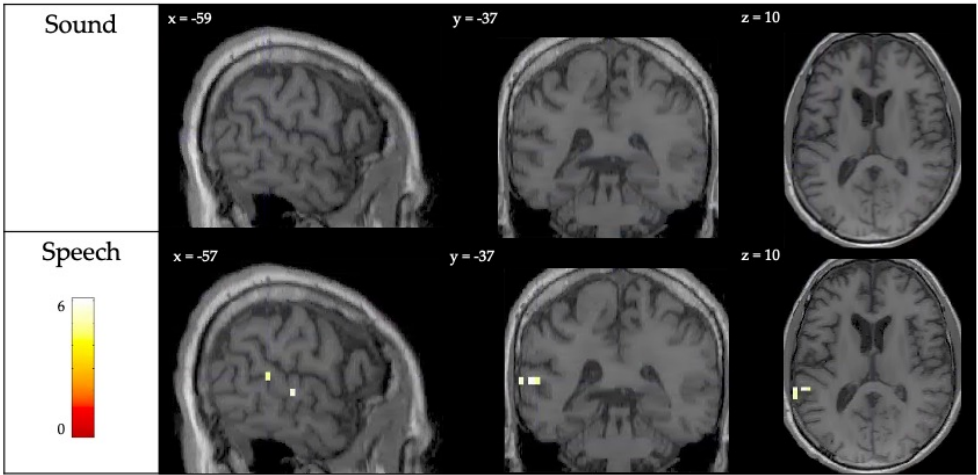
Figure 4. Neural responses to the auditory perception paradigm when comparing differences in activity between the recovery and acute scan (Recovery > Acute). Individual patient results are thresholded at p < 0.05, FWE corrected for multiple comparisons.